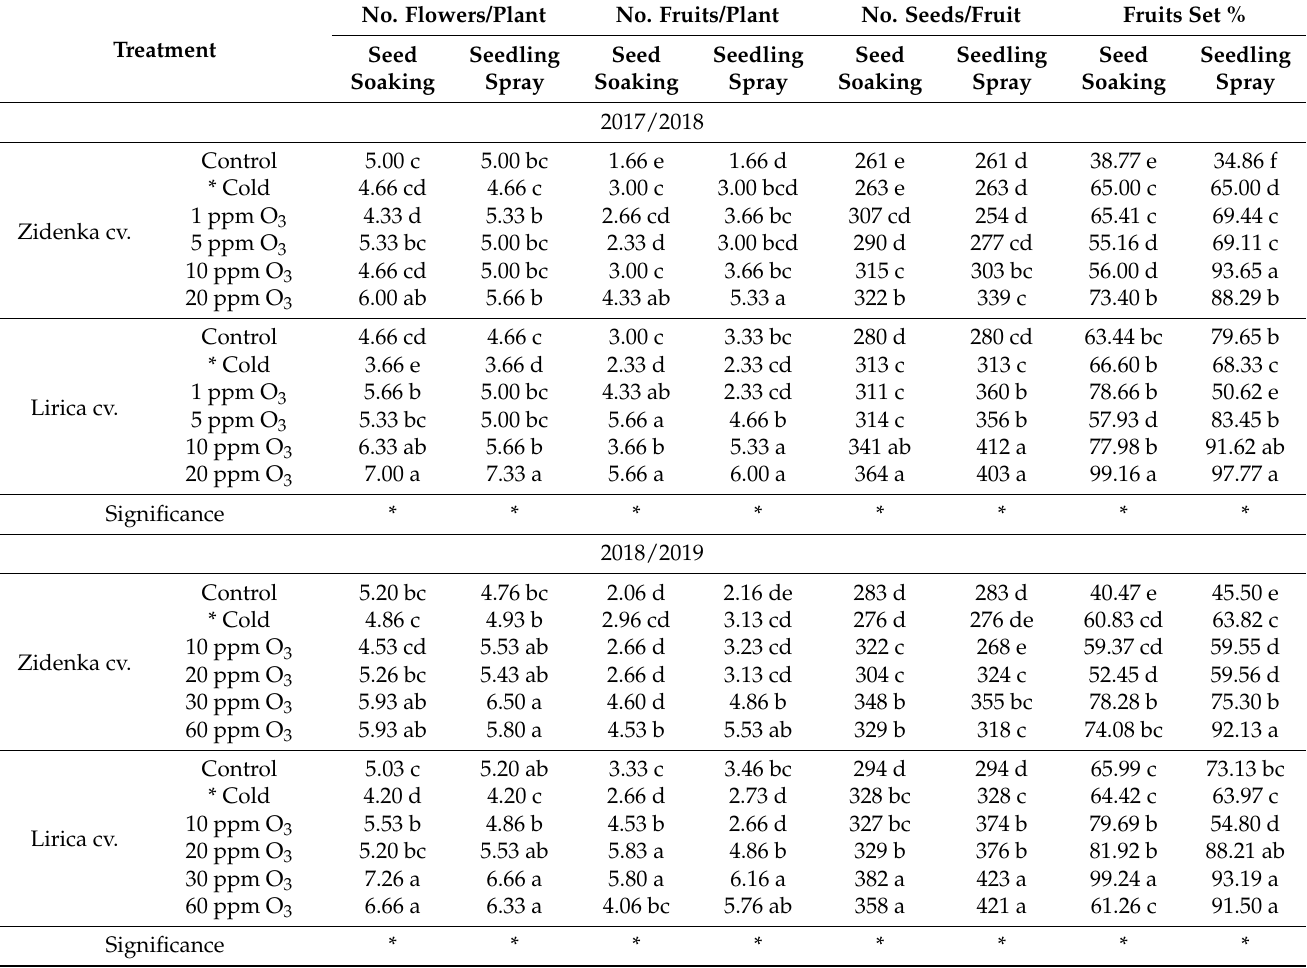
Table 5. Effect of ozone and chilling tolerance pretreatments on flowering and fruit set parameters of two sweet pepper hybrids during December and January of the 2017/18 and 2018/19 seasons.